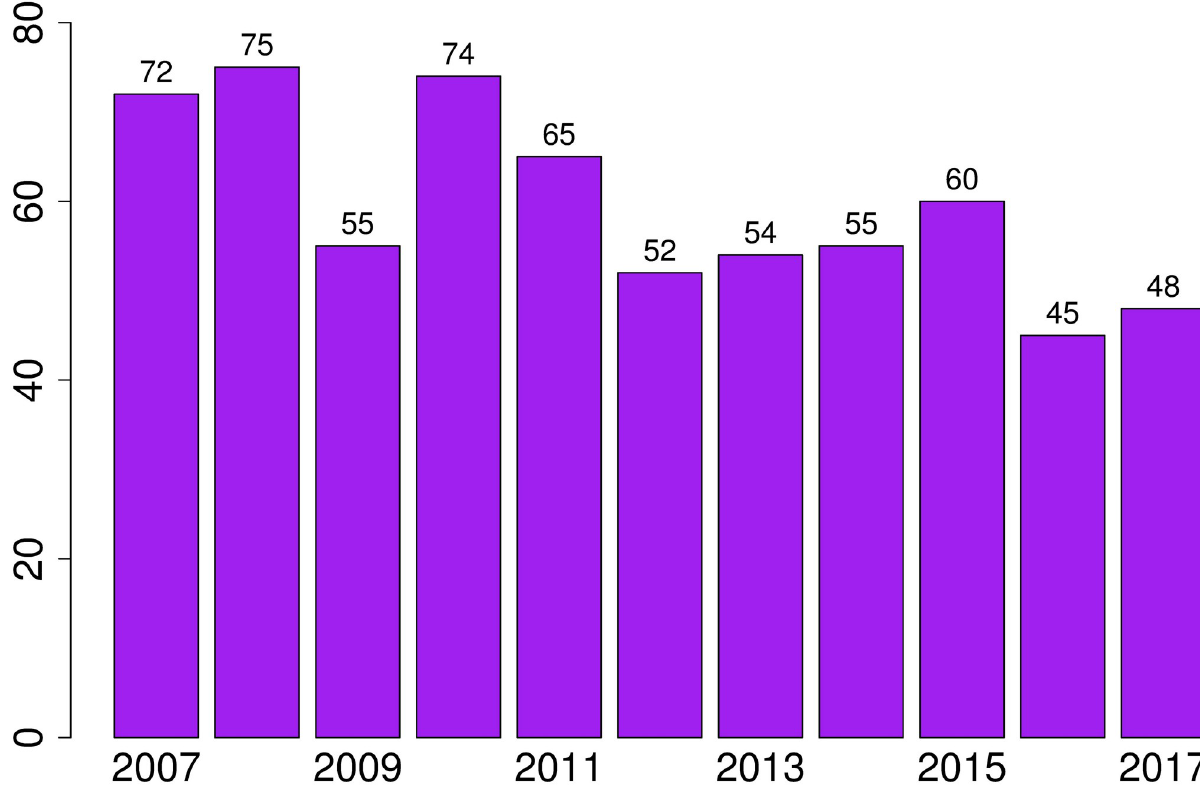
Fig 3. Femicides per year in Spain since